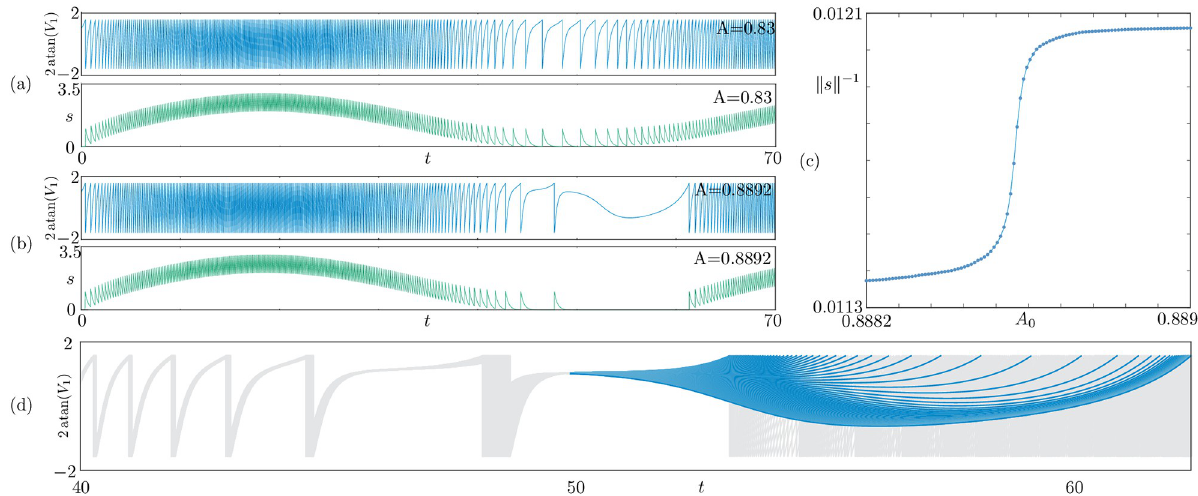
Fig 2. Continuous up-to-down route from non bursting (a) to bursting (b) states of an isolated QIF neuron in the tonic regime, upon increasing the amplitude of A of the slow forcing. (a): The non-bursting state is visible when A = 0.83; the cell exhibits a tonic state with slow frequency modulations, because the solution hovers on the top branch of Fig 1f, without jumping down. (b): When the forcing amplitude is increased slightly ( A = 0.8892) we observe a bursting solution, jumping from the top to the bottom branch of Fig 1f. (c): a continuous path connects the orbits in (a,b), as A is varied in a narrow band of values; the figure shows the reciprocal of the integral k s k of s ( t ) in t 2 [0, 70] as a function of A ; the sharp increase is typical of canard transitions. (d): we plot 100 solutions along the path in (c), near the sharp increase; the trajectories (grey) are superimposed, and the canard segments are highlighted in blue; with reference to Fig 1h, solutions morph from up-up to up-down states, while growing a canard segment of type 3–4. Parameters: ε = 0.1 J = 6, τ = 0.3, η 1 = 0.5. s